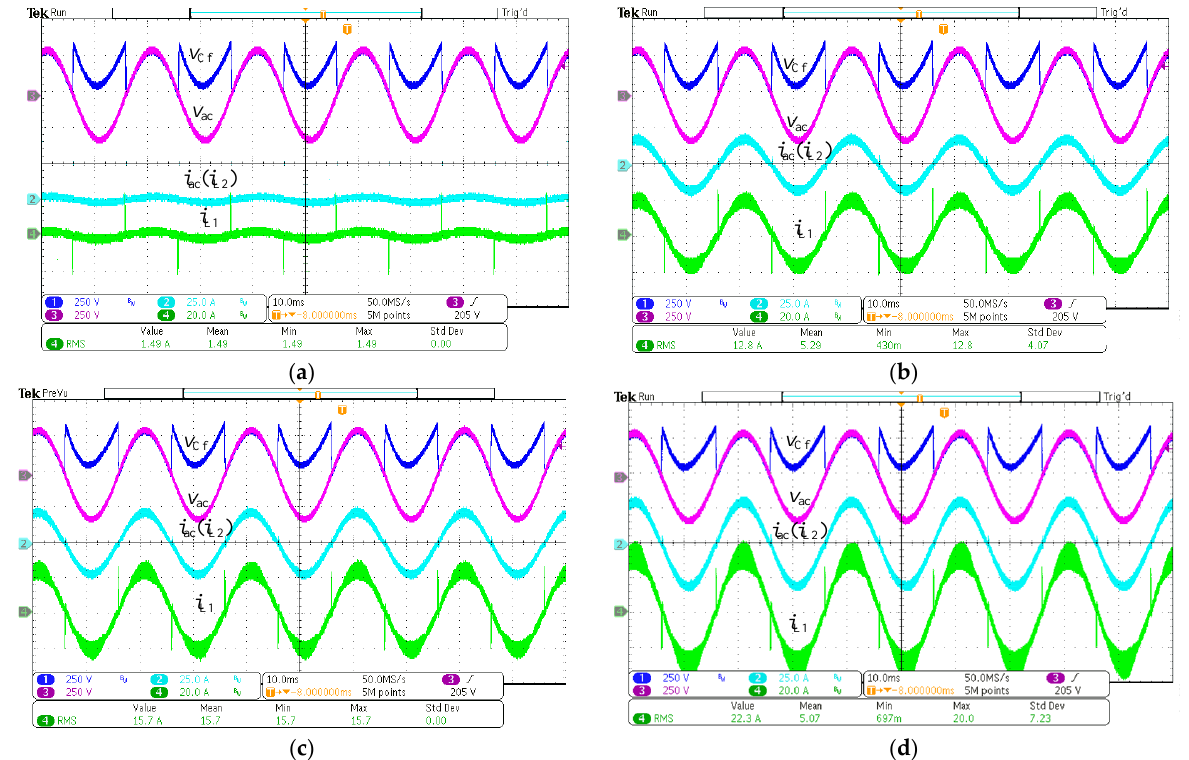
Figure 11. Steady-state waveforms of the PFC at PFC mode. ( a ) 0.5 kW, ( b ) 1 kW, ( c ) 2.5 kW, and ( d ) 5 kW.